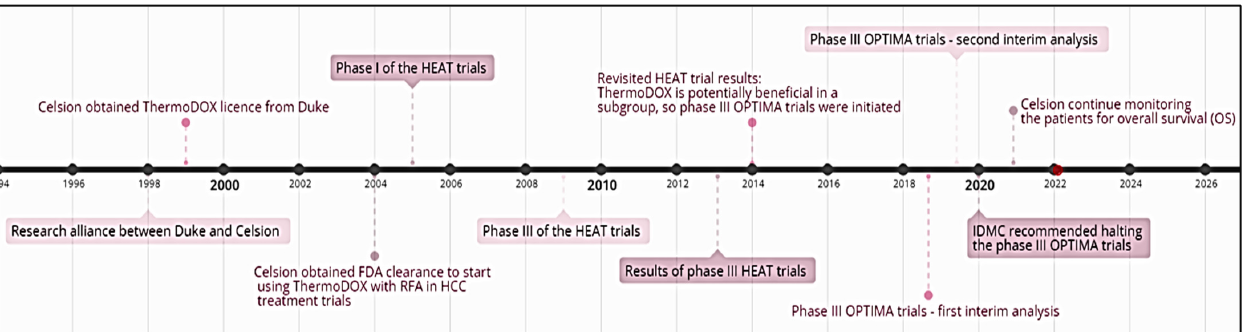
Figure 6. Timeline detailing the progress of ThermoDOX in clinical trials from 1998 onwards.